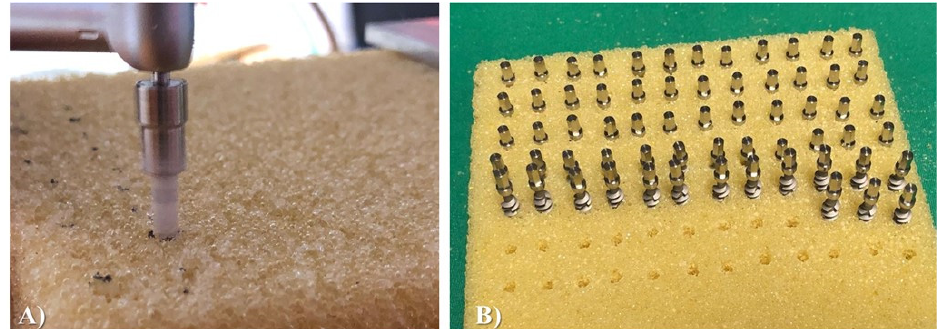
Figure 3. Experimental procedure of the investigation: ( A ) Polyurethane block drilling for implant positioning; ( B ) Dental implant positioned into the synthetic block.